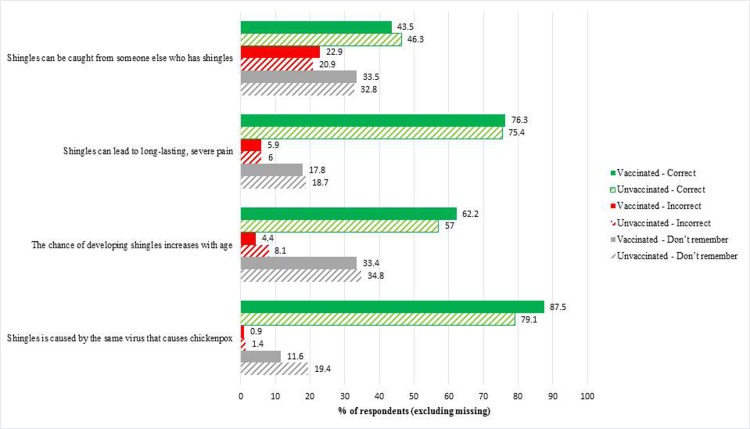
True knowledge about shingles among responders.Note: “Shingles can be caught from someone else who has shingles.” (Correct answer: false); “Shingles can lead to long-lasting, severe pain.” (Correct answer: true); “The chance of developing shingles increases with age.” (Correct answer: true); “Shingles is caused by the same virus that causes chickenpox.” (Correct answer: true).